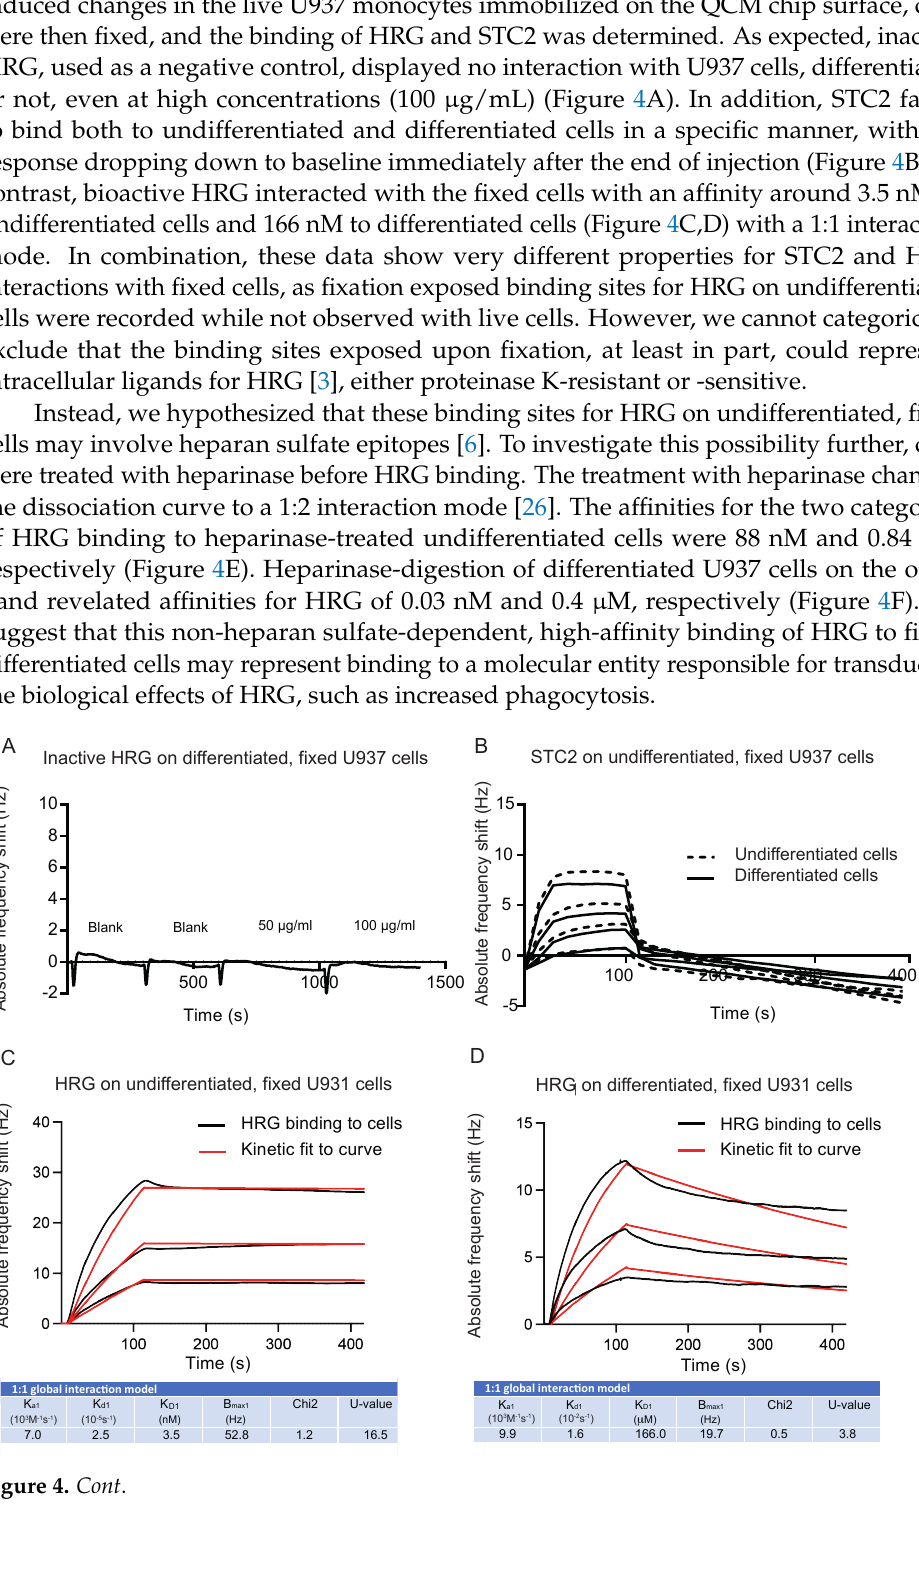
curveHRG binding to cells Kinetic fit to